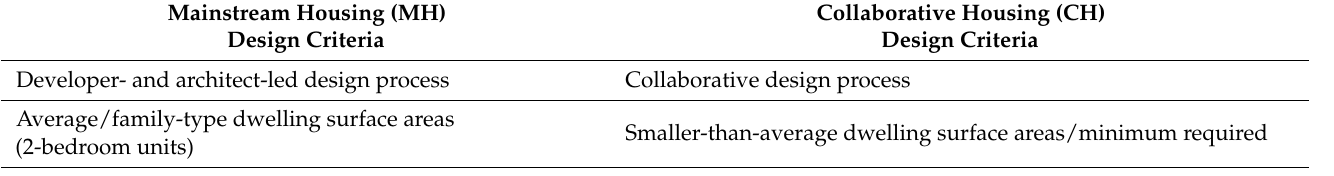
Table 1. Distinguishing design criteria of affordable MH and CH (Source: